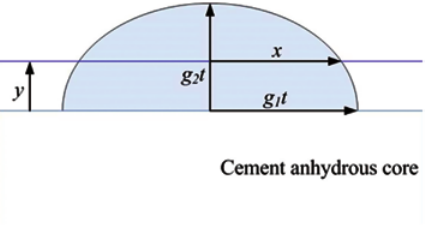
Figure 2 Schematic illustration of nuclei growth on a cement parti- cle (half-ellipsoid